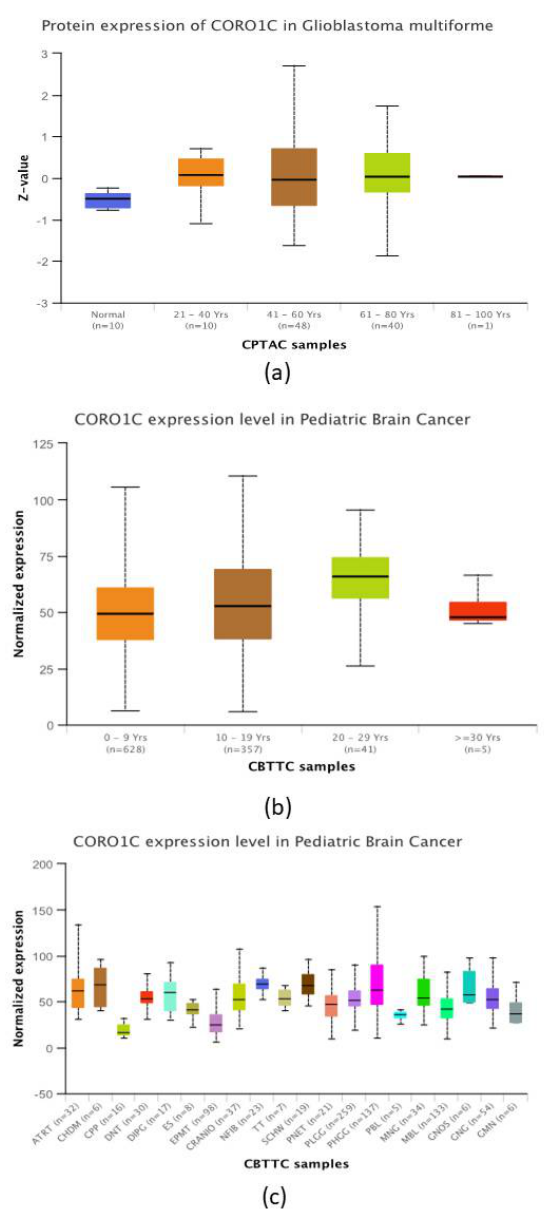
Figure 4. UALCAN comparative analysis of the expression of CORO1C within adult and paediatric glioblastoma patients. ( a ) Significantly high total protein levels of CORO1C were observed in all age groups compared to a normalised sample, except age group 81–100 years (normal versus age 21–40 years, p < 6.015973 × 10 − 3 ; normal versus age 41–60 years, p < 4.724525 × 10 − 4 ; normal versus age 61–80 years, p < 1.753039 × 10 − 3 ). ( b ) CORO1C expression was higher in age groups 0–9 years, 10–19 years, and 20–29 years in comparison to their counterparts at age ≥ 30 years of age. However, there was no statistical significance of expression between the different age groups. ( c ) Neurofibroma, chondroma, schwannoma, PHGG, and DIPG showed highest expression levels of CORO1C. Neurofibromas had significantly higher expression of CORO1C in comparison to PHGG ( p < 3.217085 × 10 − 2 ). PLGG, DIPG, CRANIO, PTEN, ES, DNT, and CPP subtypes have significantly lower expressions of CORO1C in comparison to PHGG (PLGG versus PHGG, p < 2.50863678369934 × 10 − 7 ; DIPG versus PHGG p < 3.535811 × 10 − 3 ; CRANIO versus PHGG p < 5.516405 × 10 − 3 ; PTEN versus PHGG p < 2.994696 × 10 − 3 ; ES ver- sus PHGG p < 5.98540311685281 × 10 − 8 ; DNT versus PHGG p < 1.163218 × 10 − 2 ; CPP versus PHGG p < 1.75021275936207 × 10 − 18